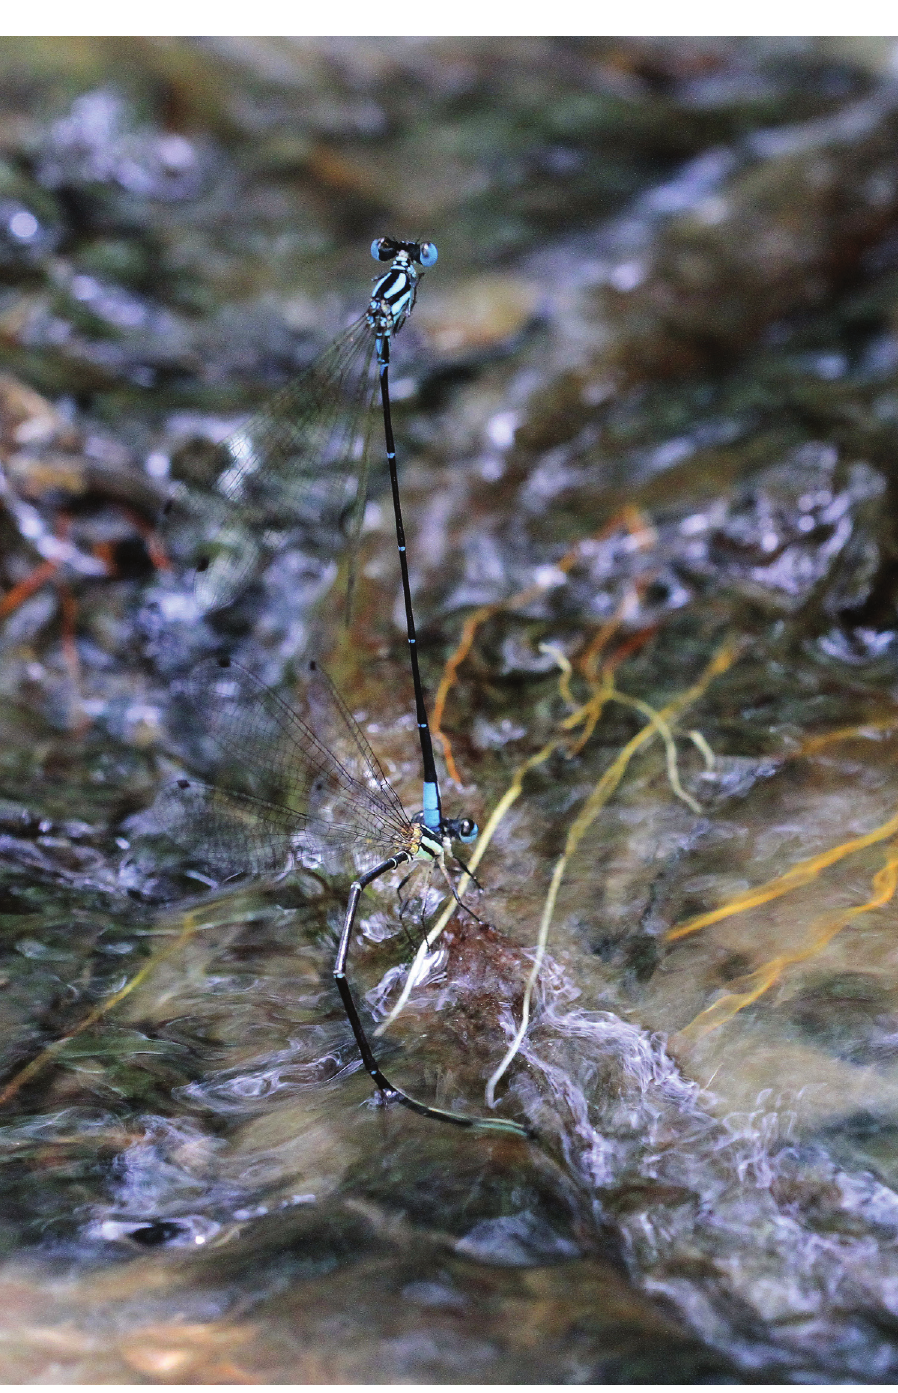
Figure 1. Allocnemis marshalli ovipositing in tree roots in a small mountain stream near Chingombe, Zambia (phot. B.